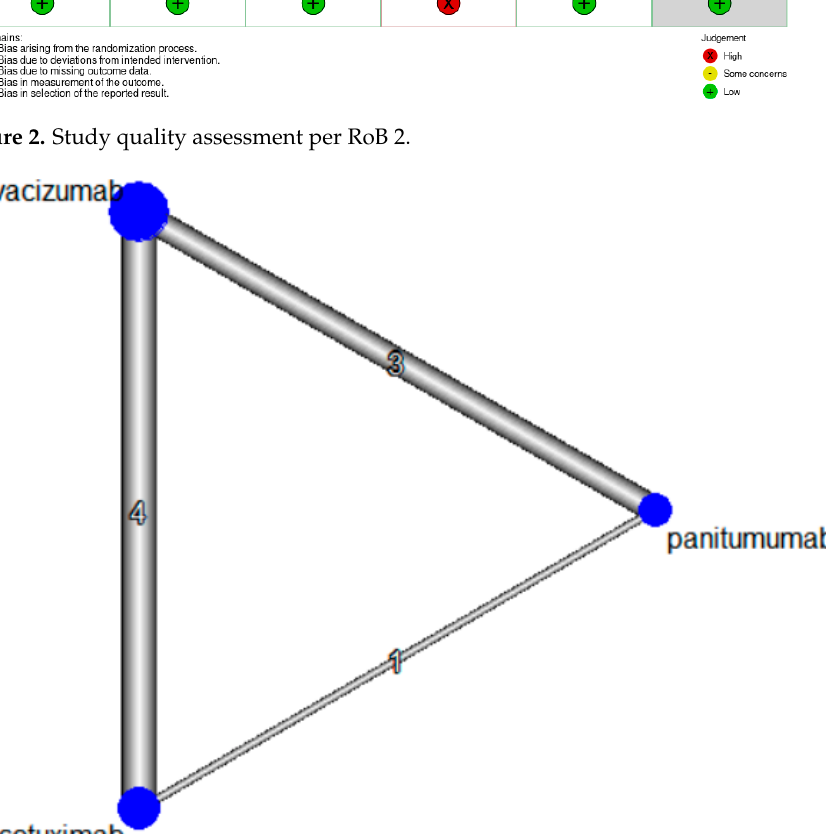
Figure 3. Network plot of included studies. Diameters of the blue circle represent the proportion of patients included in the analysis, and thickness of the lines is weighted by the number of the studies comparing two interventions.